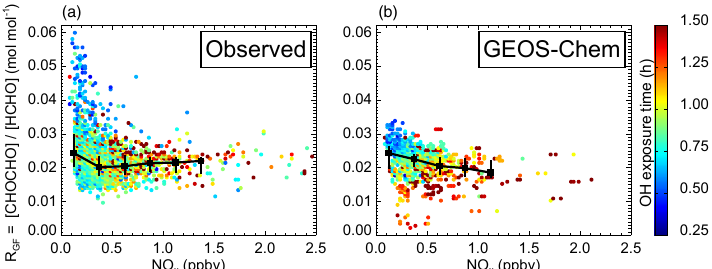
Figure 6. Dependence of the CHOCHO-to-HCHO ratio R GF on NO x concentrations for the SENEX conditions. Observations below 1km altitude (a) are compared to GEOS-Chem model values sampled along the flight tracks (b) . Points are color coded by the OH exposure time t OH (Eq. 1). Binned median and interquartile R GF values in increments of 250pptv NO x for bins with more than 20 values are also